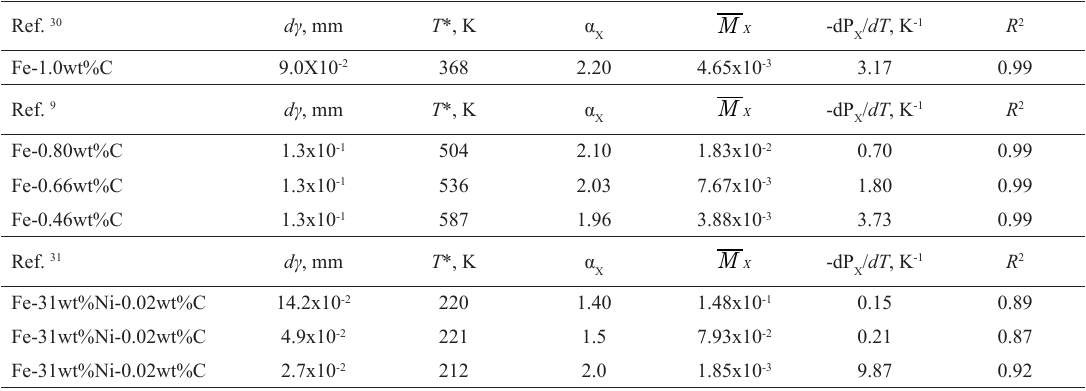
Table 2: Time-independent transformations